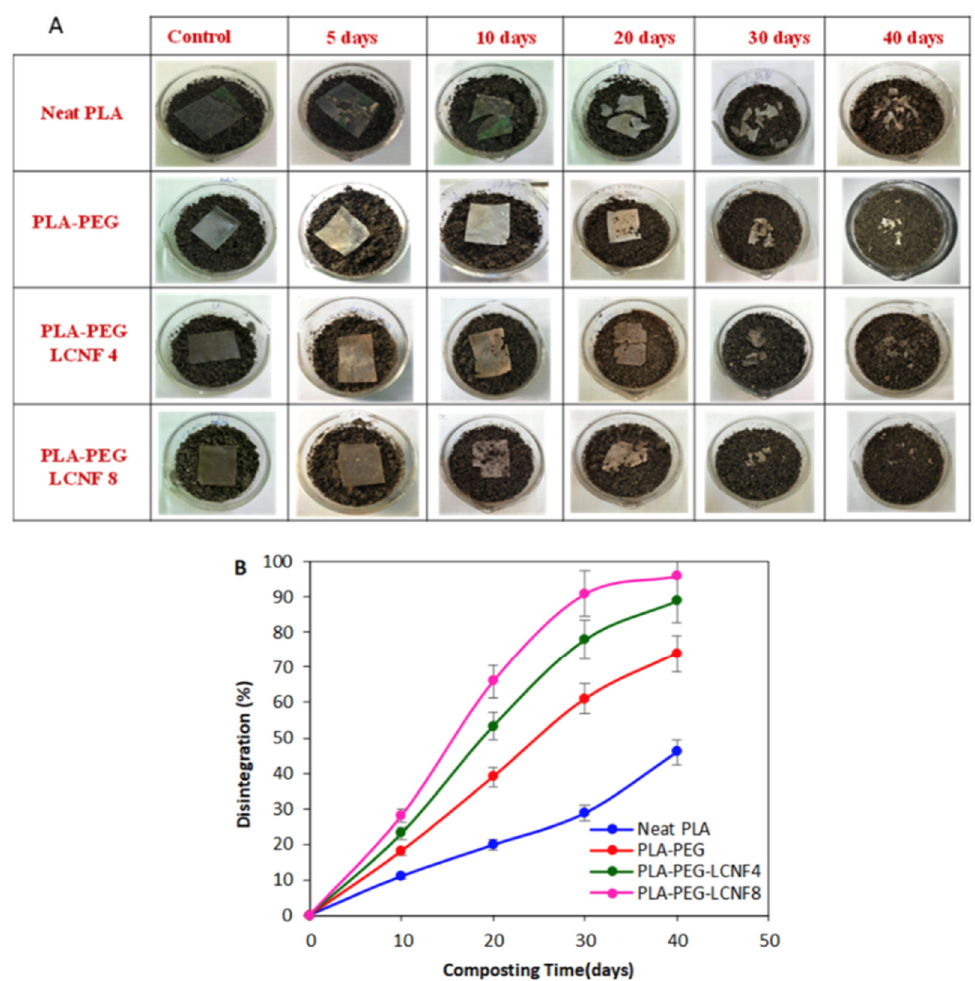
Figure 23. ( A ) Visual observation of PLA and PLA/PEG/LCNF nanocomposites after different days under composting environment and ( B ) disintegration degree under composting conditions as a function of time [263].